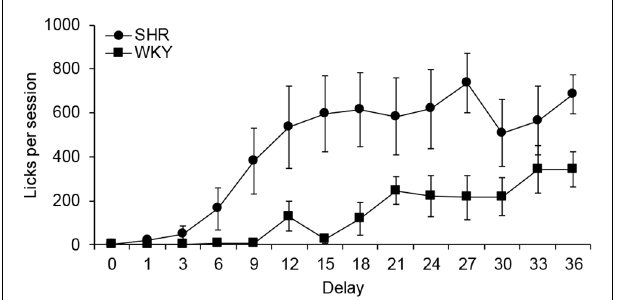
FIGURE 4 | Mean total licks per session at each delay for each group. Circles depict data from SHR rats, and squares from WKY rats. Vertical bars denote standard error of the